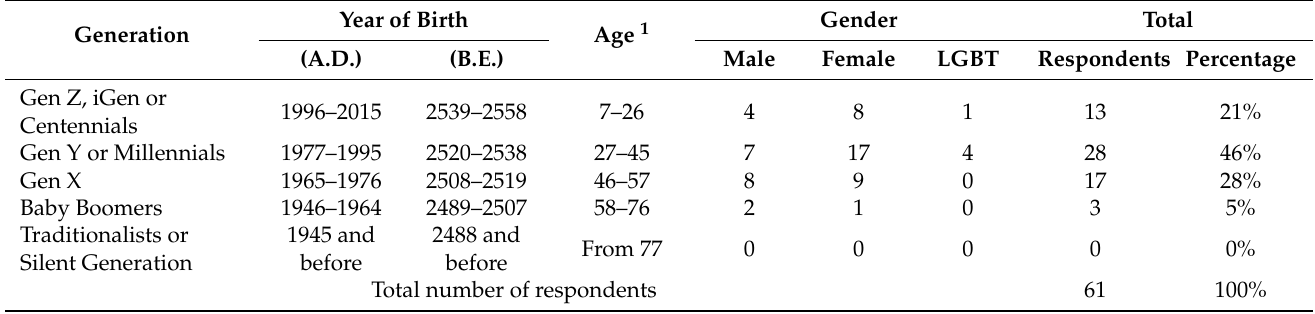
Table 1. Numbers of respondents classified by generation and gender